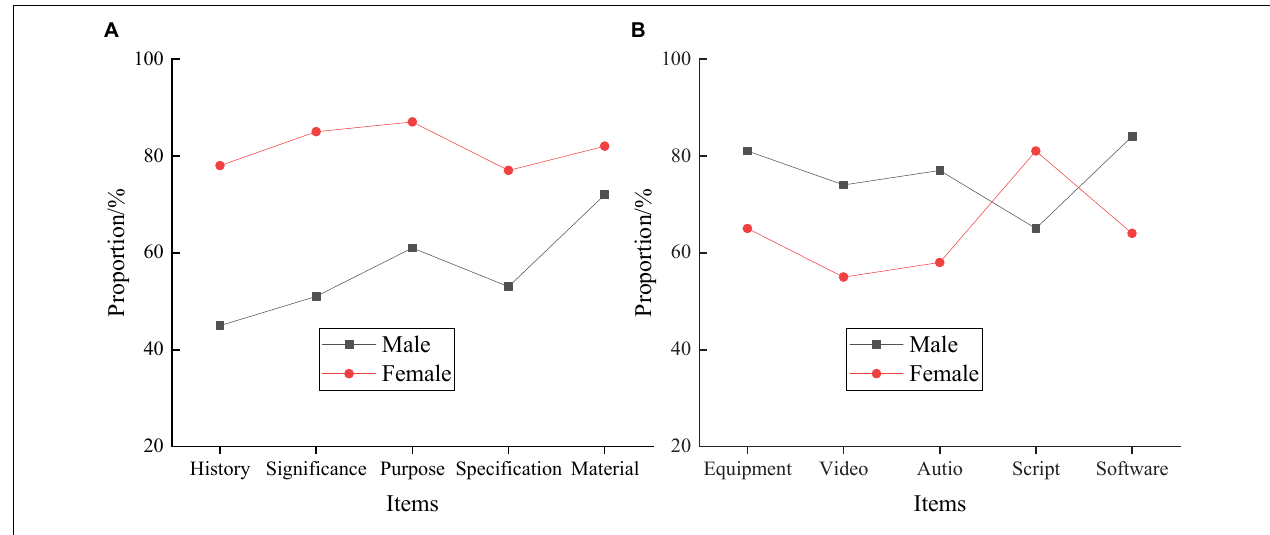
FIGURE 4 | EPSY-based teaching effect evaluation of Cinematography Major through gender classification. (A) Theoretical knowledge. (B) Creative